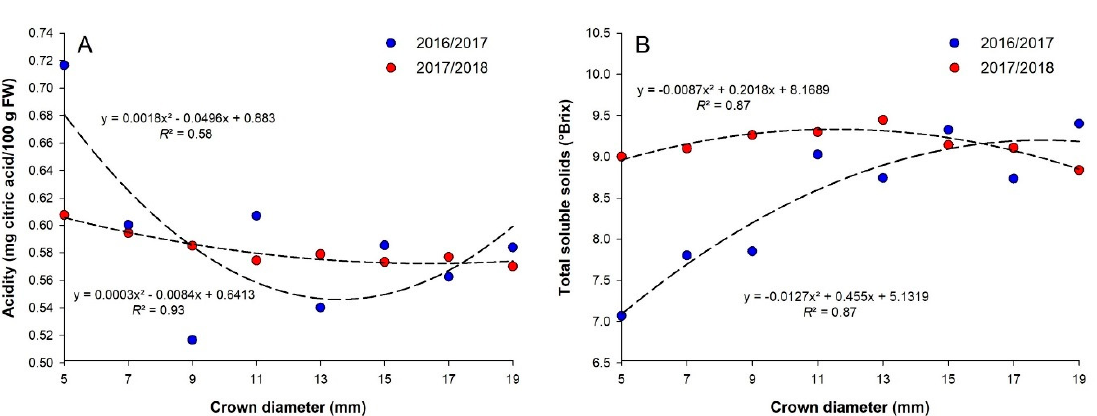
Figure 4. The titratable acidity ( A ) and total soluble solids content ( B ) in the fruits of strawberry plants cv. ‘Pircinque’, depending on different crown diameters of the plants (5, 7, 9, 11, 13, 15, 17, and 19 mm) during the 2016/2017 and 2017/2018 production cycles.